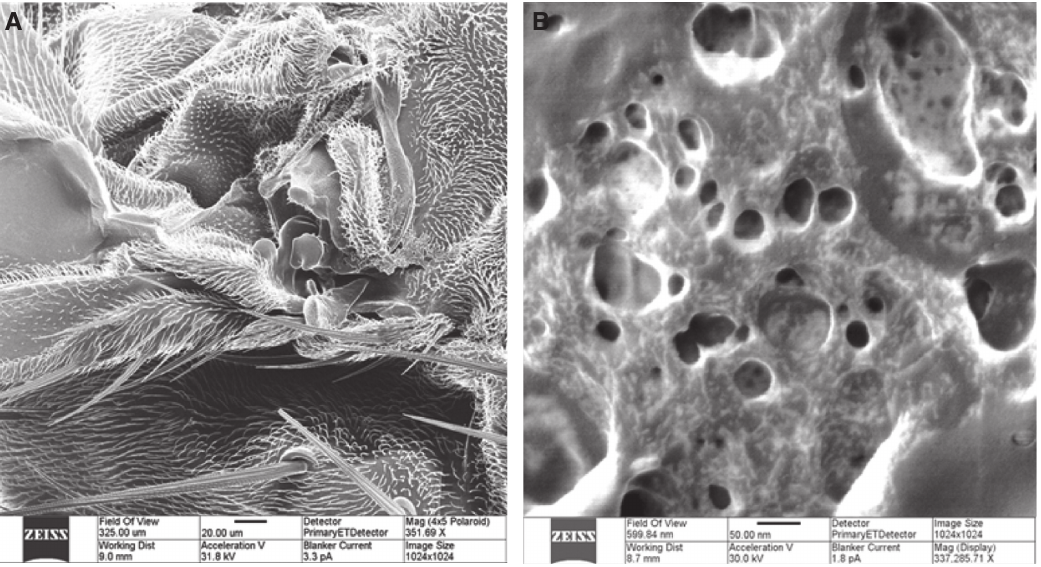
Figure 11 (A) HIM images of the native cuticle of Drosophila melanogaster demonstrating the elaboration of chitin polymer-based struc- tures and sensory organs. (B) Ultrahigh-resolution image of purified chitin. Note the presences of nanoscale holes and